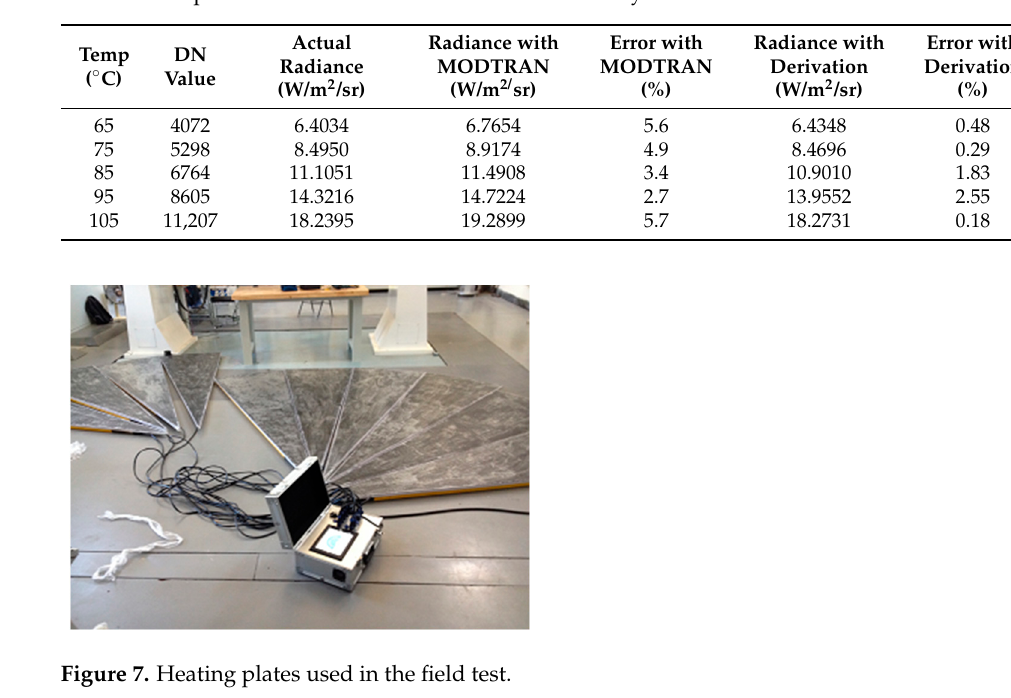
28 degrees C, shown in Figure 8.